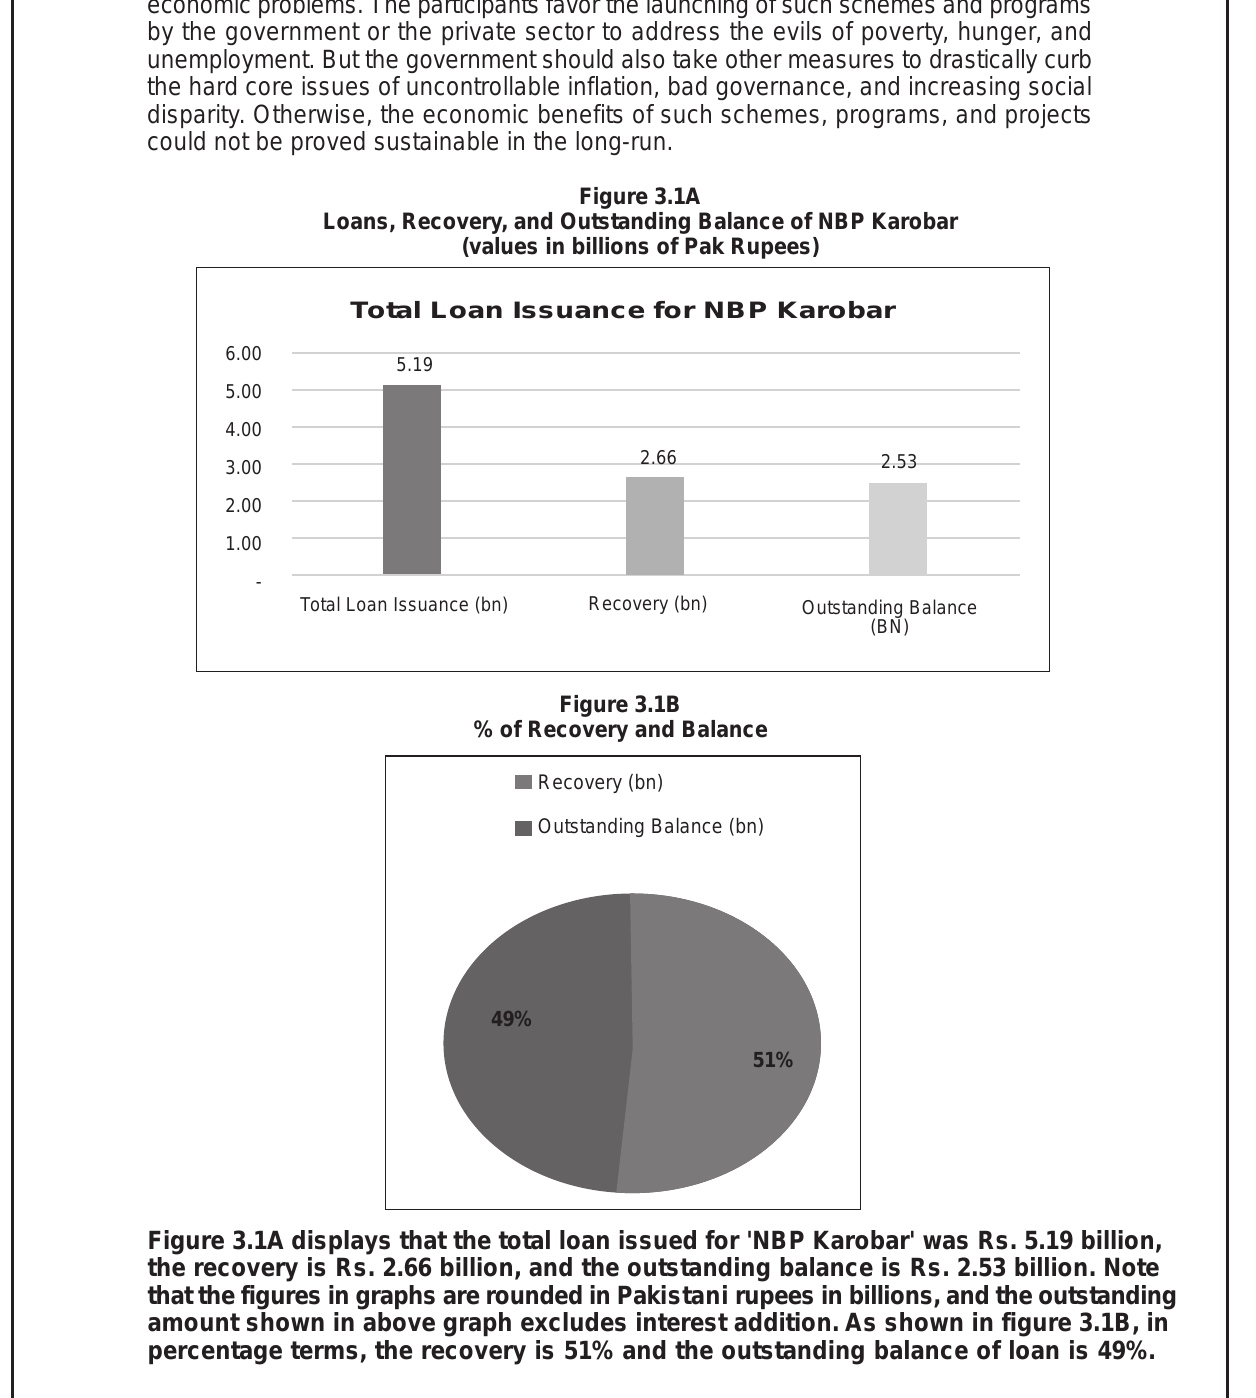
Figure 3.1A Loans, Recovery, and Outstanding Balance of NBP Karobar (values in billions of Pak Rupees)